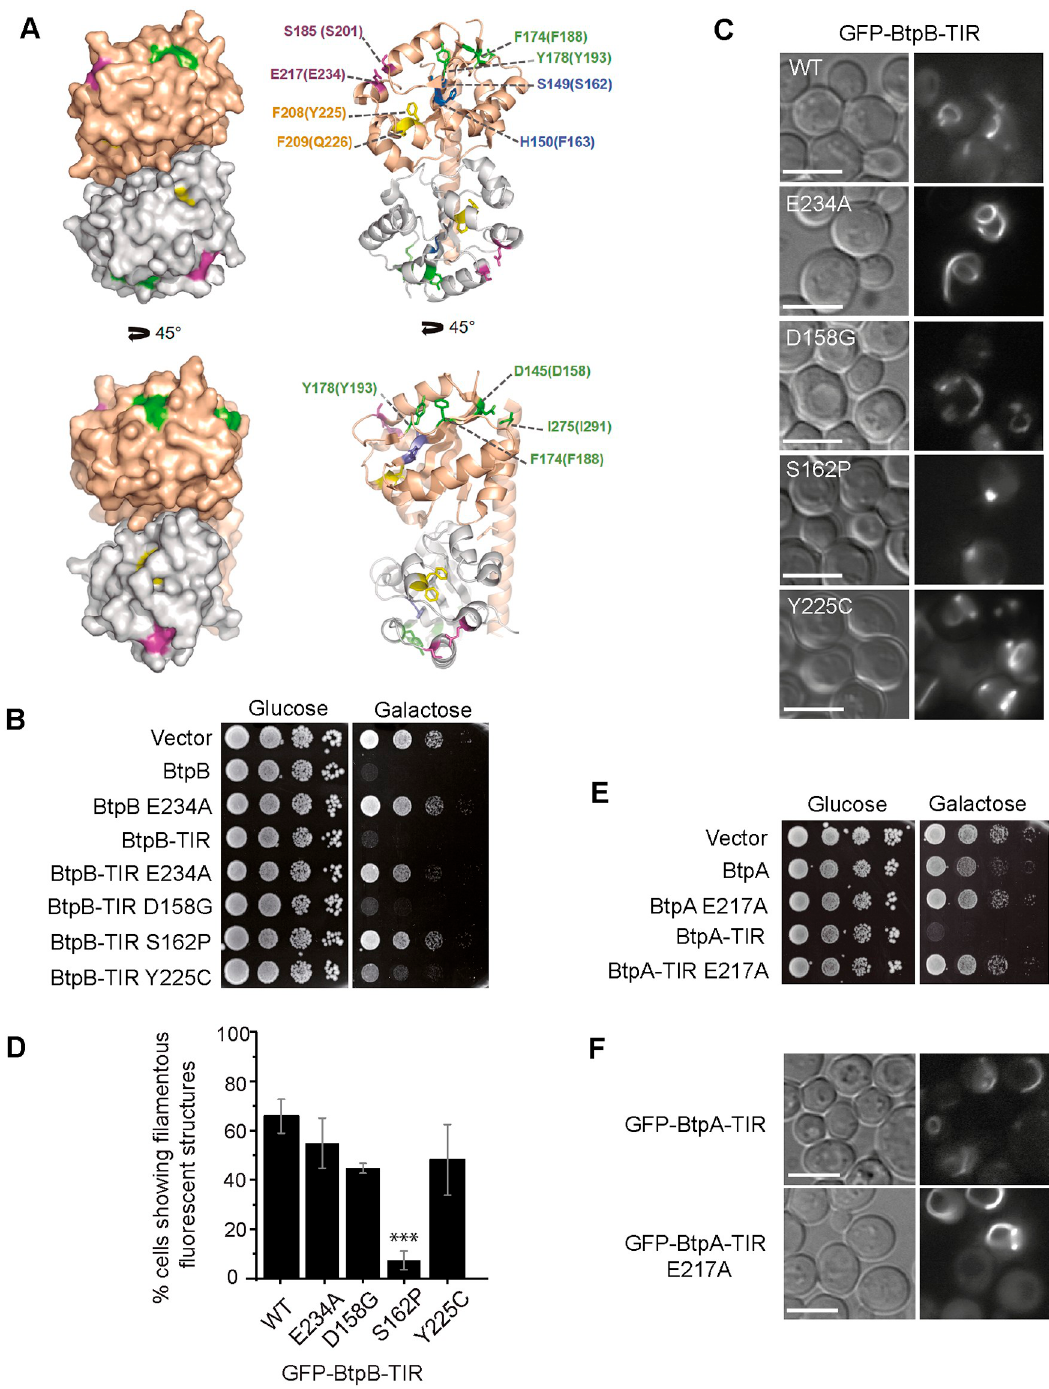
Fig 4. Functional analysis of BtpB and BtpA mutations in yeast. (A) Structure of BtpA-TIR domain showing the positions equivalent to those identified as loss-of-function in BtpB by yeast random mutagenesis screening. Left panels: two views of BtpA-TIR dimer structure (PDB: 4LZP) with chain A colored in wheat and chain B in grey. Residues identified are colored according to their assigned properties. Positions of the mutations putatively affecting protein folding are colored in blue ( β A strand) and yellow ( α C helix). Mutations at the active site are colored in magenta. Mutations at the surface outside the active site are colored in green. Right panels: views in the same orientation of the BtpA dimer depicted as cartoon with the side chains of mutated residues displayed as ball-and-sticks. Residue numbers are indicated for BtpA and the corresponding residues in BtpB are in parenthesis. (B) Ten-fold serial dilution growth assay of YPH499 cells expressing pYES2 empty vector, BtpB full-length, BtpB-TIR and the indicated mutants